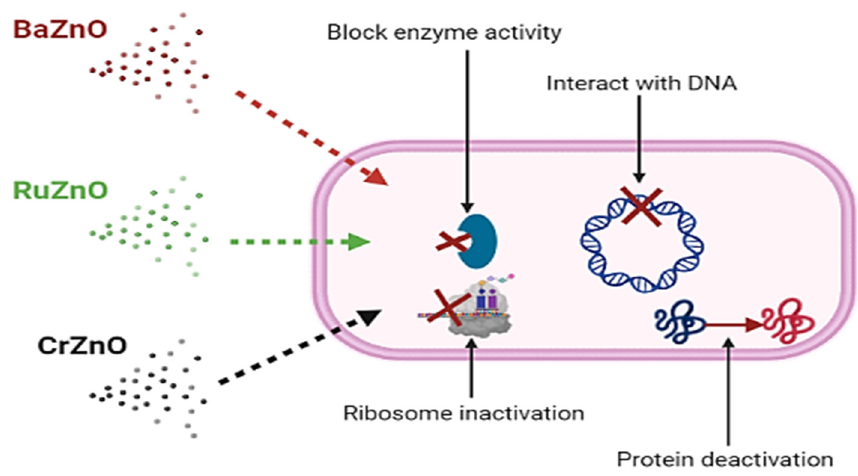
Figure 5. The possible mechanisms of the BaZnO, RuZnO, and CrZnO nanomaterials fabricated via the co-deposition method.